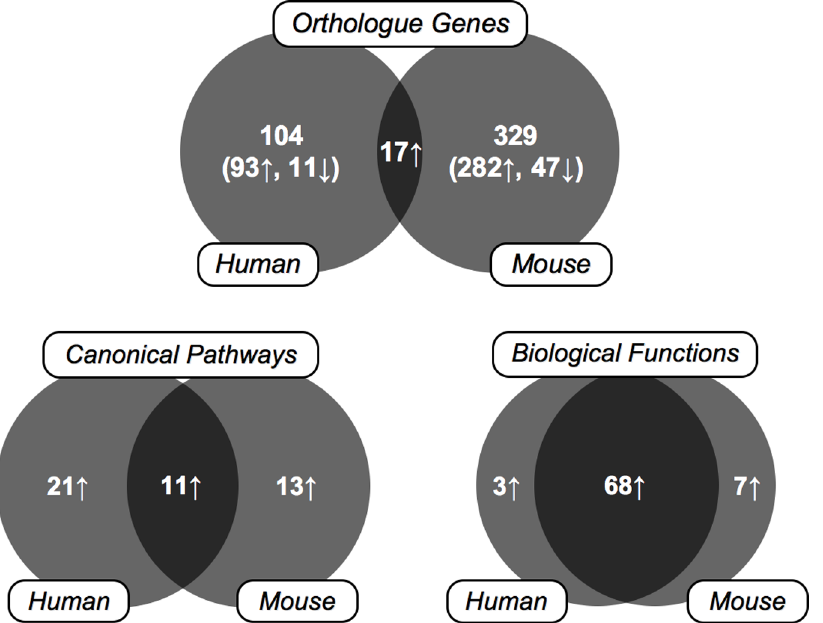
Figure 1. Venn diagram representing the number of orthologue genes, canonical pathways and biological functions induced by cigarette smoke and shared between humans and mice.